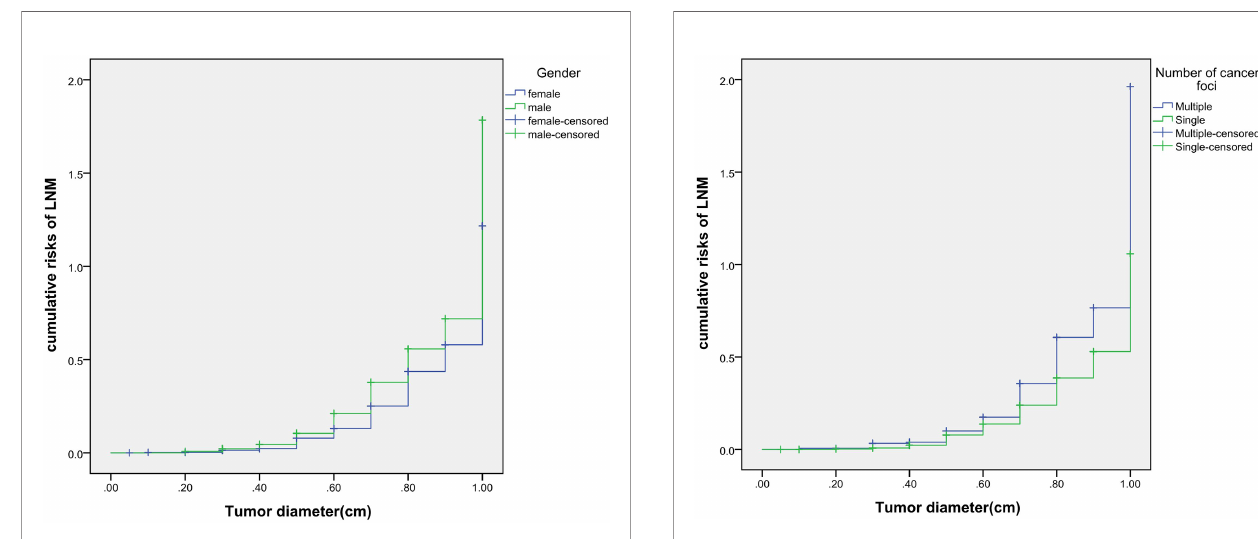
FIGURE 3 | Cumulative risks of LNM according to gender and tumor